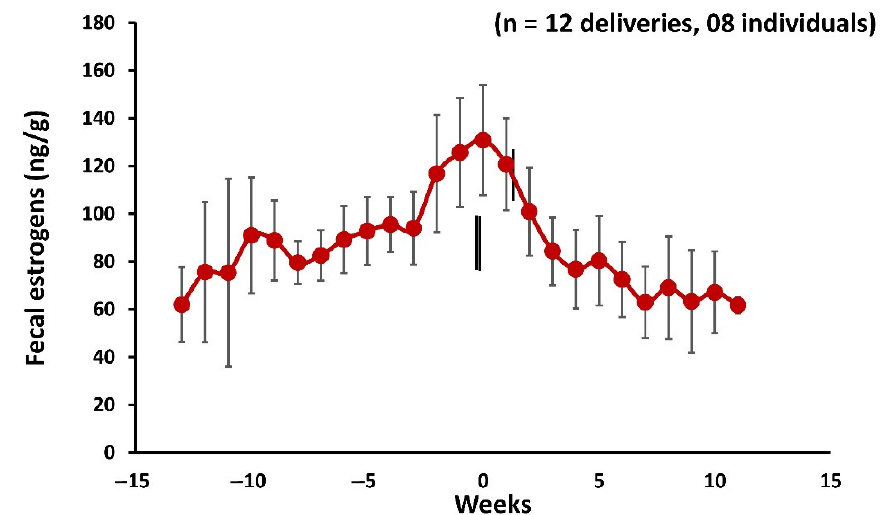
Figure 8. Profile of mean ± SEM weekly fecal estrogens in mouse deer during 11 weeks before and after parturition. The zero week and vertical bars indicate the parturition, mating, and postpartum estrus ( n = 12) were recorded in eight individuals.